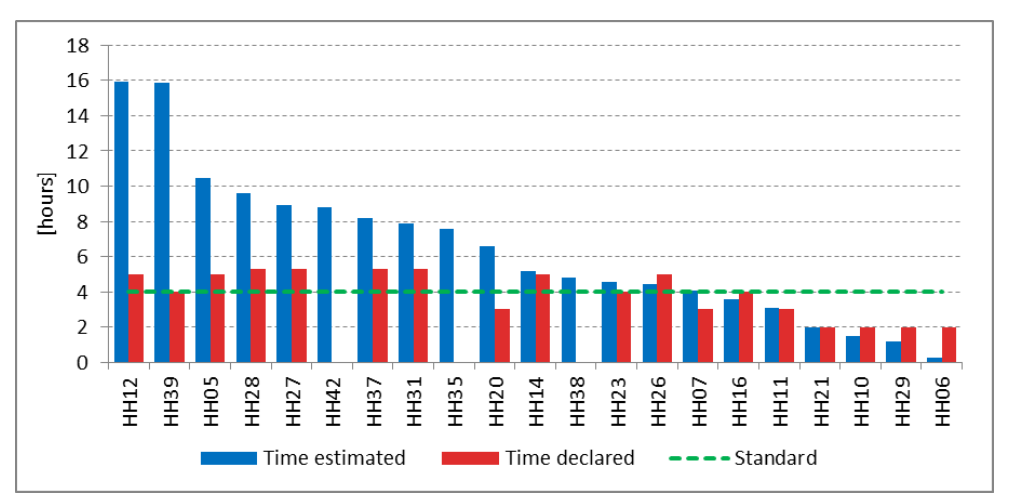
Figure 5. Relationship between nominal power and year of purchase for different LCD technologies (EL: energy label).